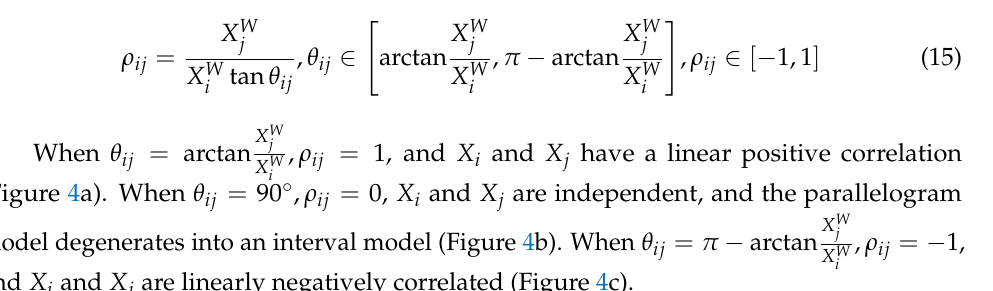
X W j , ρ ij = − 1, X W i